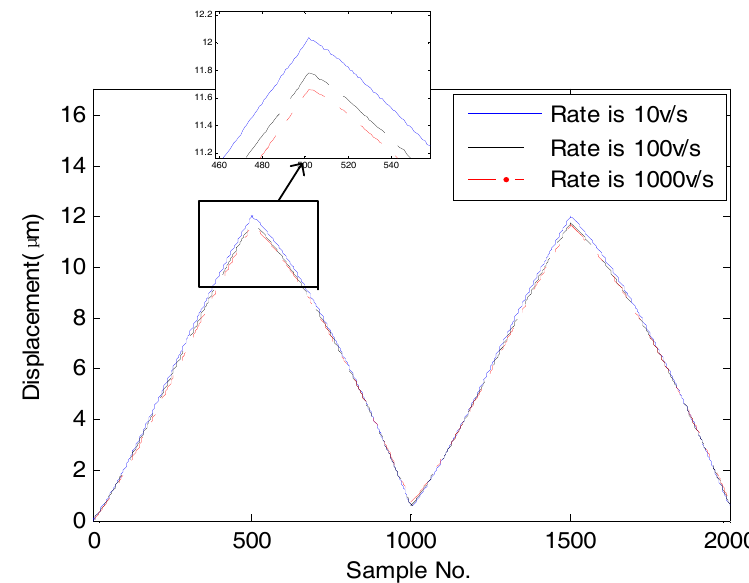
Figure 14. Displacement sequences after time-scale transformation.